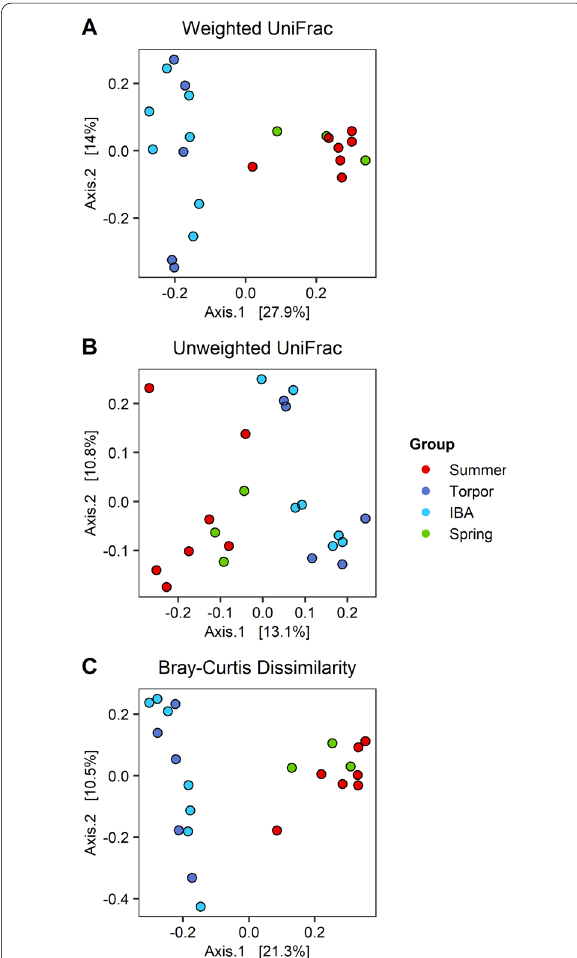
Fig. 4 Beta diversity of mucosa microbiotas from captive groups. A Weighted UniFrac, B unweighted UniFrac, and C Bray–Curtis dissimilarity are displayed on PCoA ordinations. Groups are depicted with different